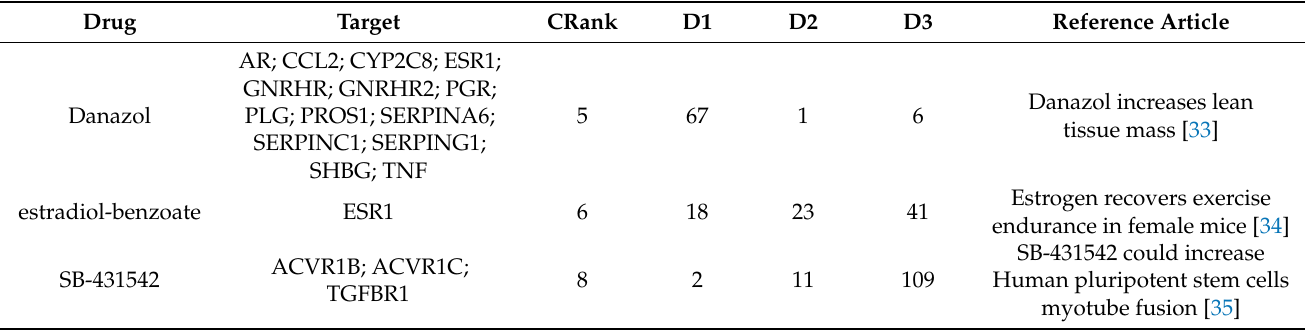
Figure 8. ( A ) 1 µ M of vorinostat increased the diameter of muscle fibers. ( B ) Density plot of myotube diameter distribution. ( C , D ) WB experiments were independently replicated two times. Repeated WB experiments confirmed that the drug intervention group (vorinostat: 1 µ M) had a higher myotube percentage. ( E ) The cell activity assays (CCK-8) indicated that vorinostat (1 µ M, 2.5 µ M, 5 µ M, 10 µ M) inhibits the activity of C2C12 cells. ( F ) Violin plots showing the different diameter distribution in the control vs. vorinostat group (****: p < = 0.0001). Table 1. Five drugs/small molecules may have a therapeutic effect on